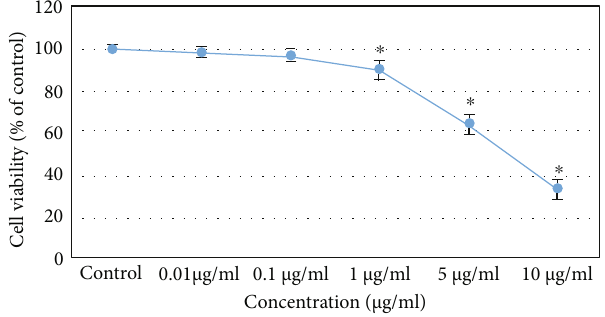
Figure 14: Cytotoxicity of CFA on BEAS-2B cells for 24 h. Each value represents the average ± SE of the three experiments n = 3 ∗ p < 0 : 5 versus